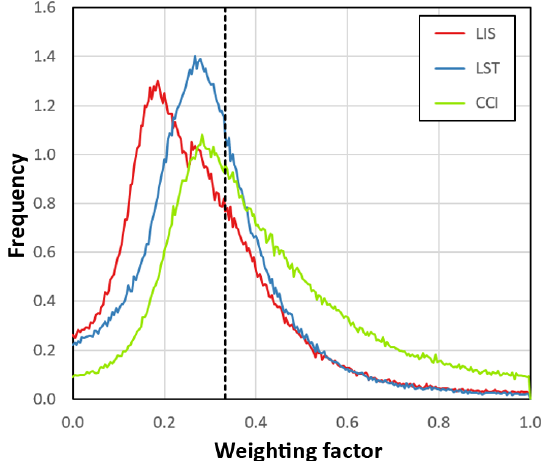
Figure 12. Frequency distribution of the ensemble mean weight- ing factor for each dataset computed according to the TC analysis. The black dotted line represents the value corresponding to a simple arithmetic average (1 /